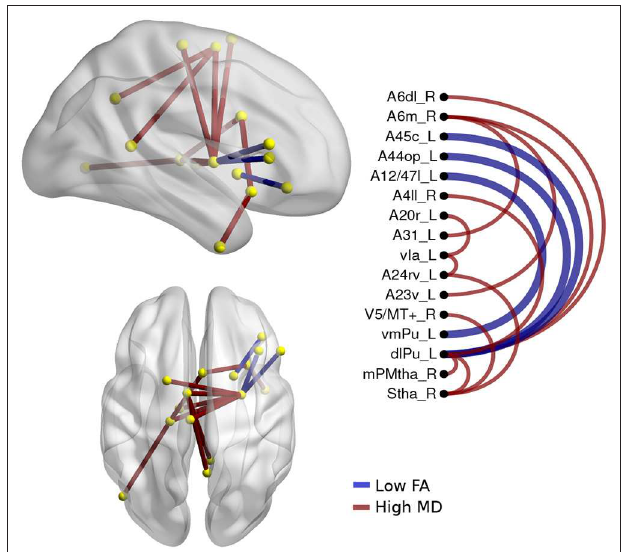
FIGURE 4 | Atrophic networks in the nfvPPA variant regarding bvFTD, the labels from Brainnetome represents the nodes, and the edges show the changes in FA and MD. Only the edges with changes are shown. The whole list of the nodes with the names is located in Supplementary Data . The left side of the figure shows alterations overlaid on a 3D template in the Montreal Neurological Institute’s standard space in neurological convention. The right side shows the same results displayed in 2D with the names of nodes in the Brainnetome Atlas and displayed at p < 0.05.